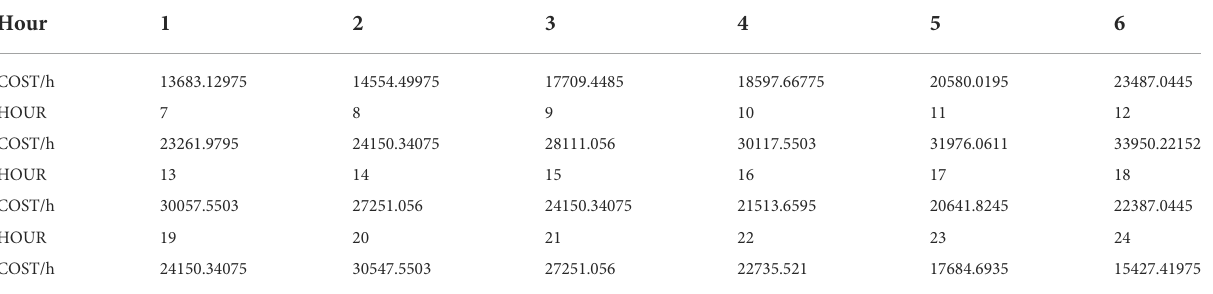
TABLE 4 Optimal operating cost per hour for 10-unit